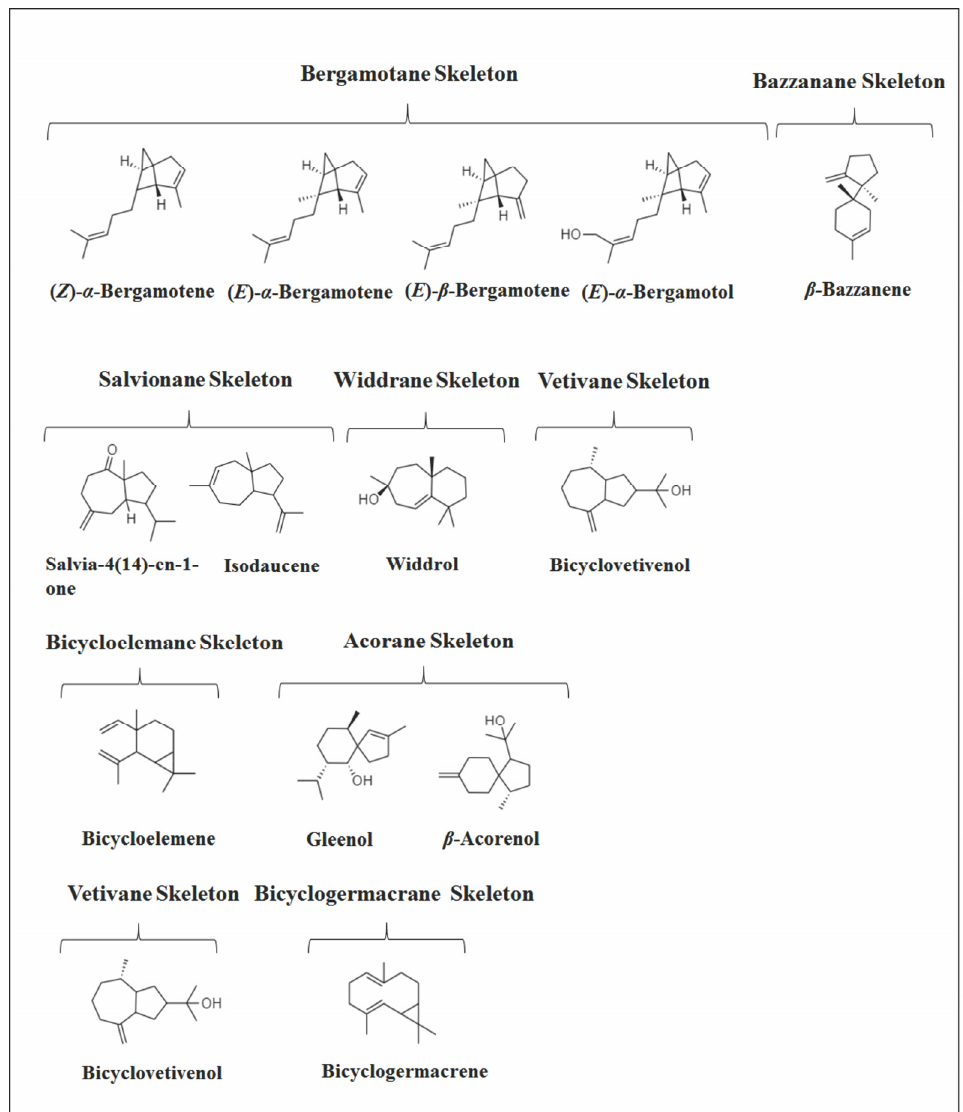
Figure 9. Structures of bicyclic sesquiterpenes in Vitex species.